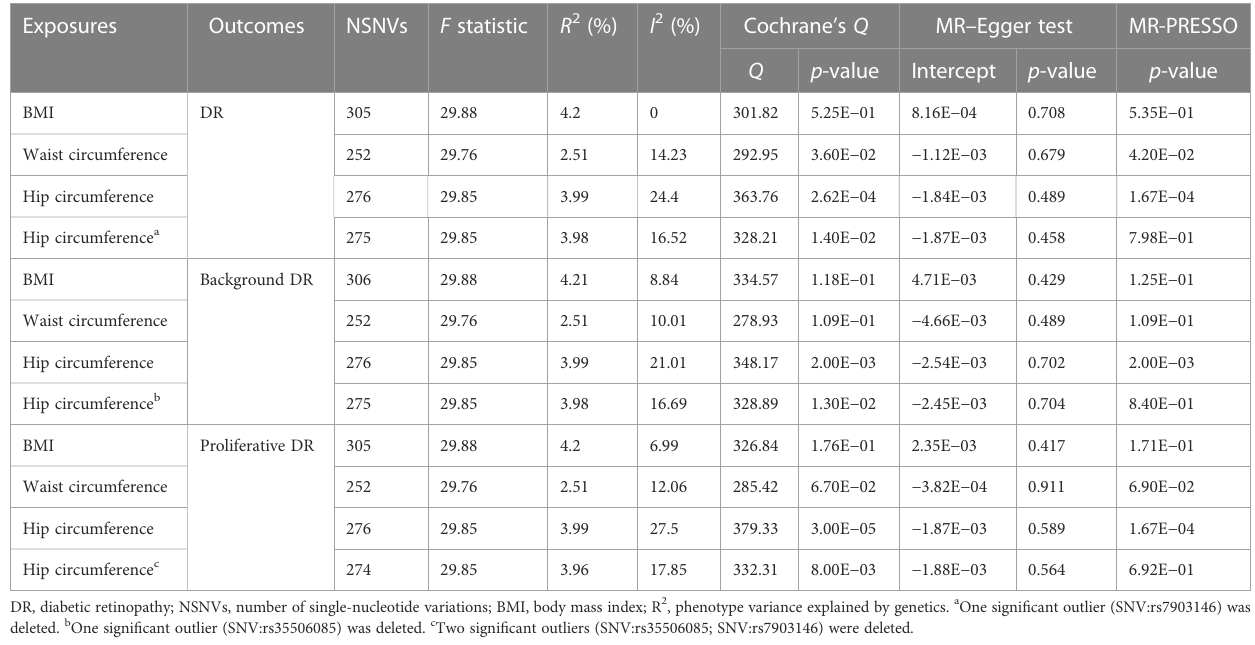
TABLE 1 Mendelian randomization results of obesity traits on DR.